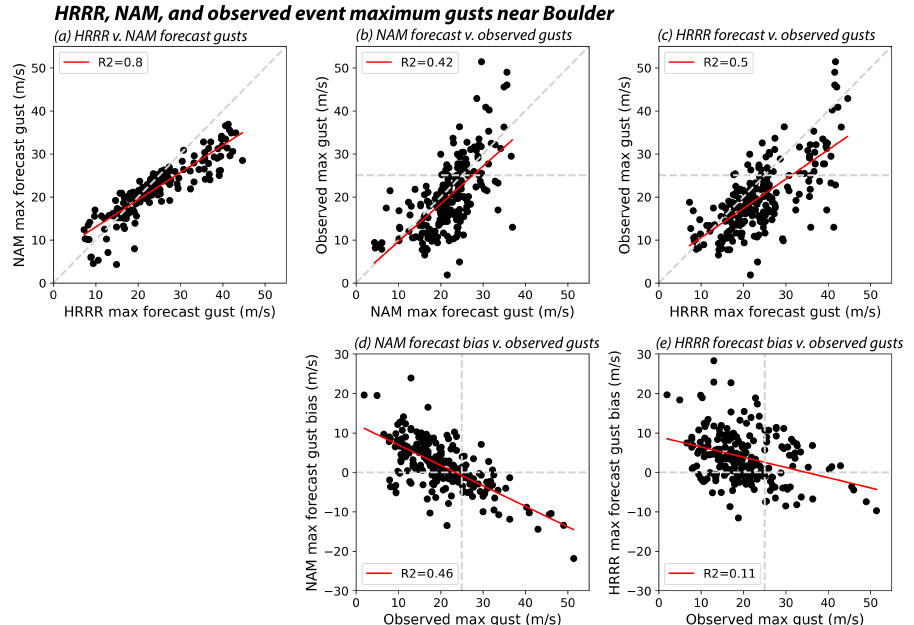
Figure 14. Scatterplots comparing maximum (max) forecast and observed gusts (m/s) from the 24 h period starting 1200 UTC 30 December for the stations shown in Figure 13. Shown are ( a ) HRRR vs. NAM max, ( b ) NAM vs. observed max, ( c ) HRRR vs. observed max, ( d ) observed max vs. NAM forecast bias, and ( e ) observed max vs. HRRR forecast bias. Bias is defined as forecast max gust minus observed max gust. Each dot is a station. Simple linear regressions (red lines) and R 2 values also shown. Gust value of 25 m/s marked on some